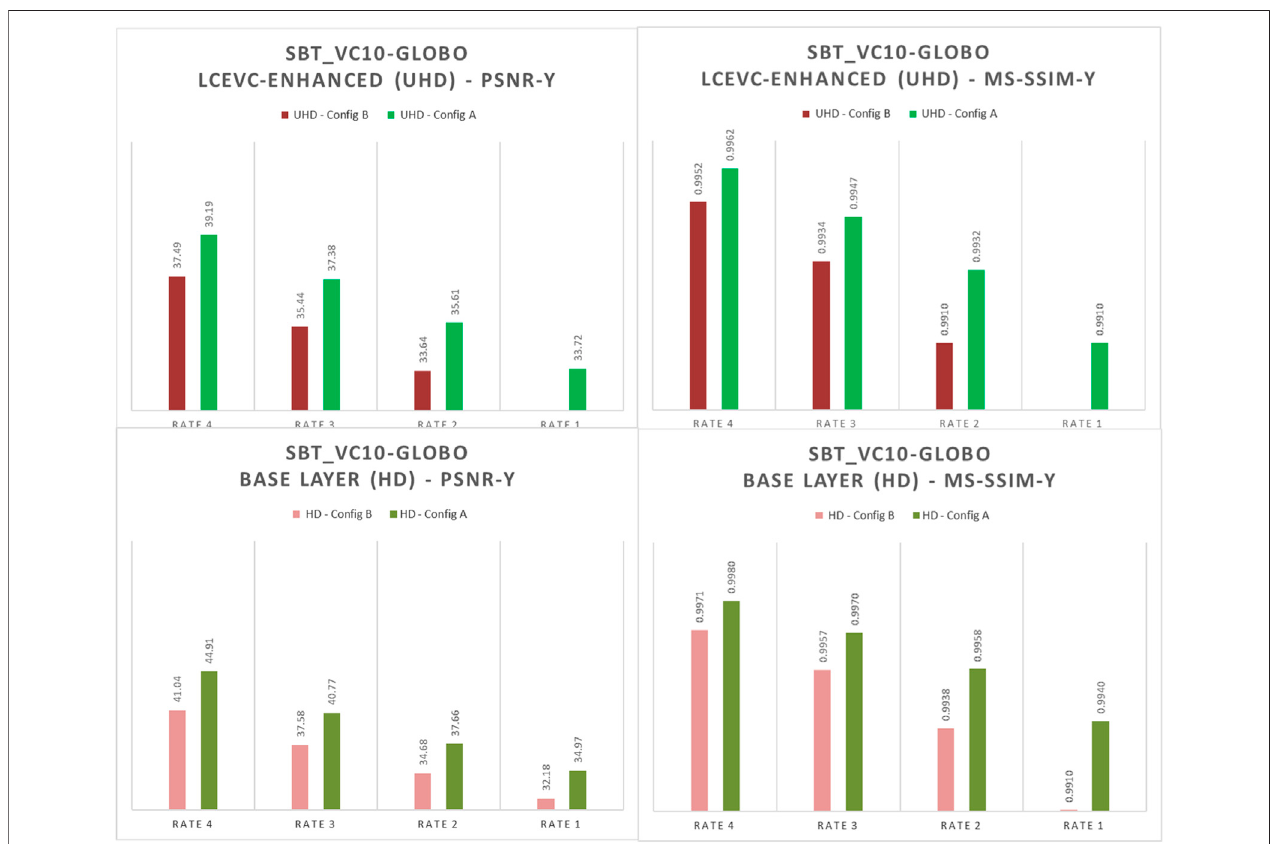
FIGURE8| ComparisonofMS-SSIM-YandPSNR-Ybetweenthebaselayers(HD)underCon fi gurationA(green)andCon fi gurationB(red) – SBT_vc10-globo(PQ)